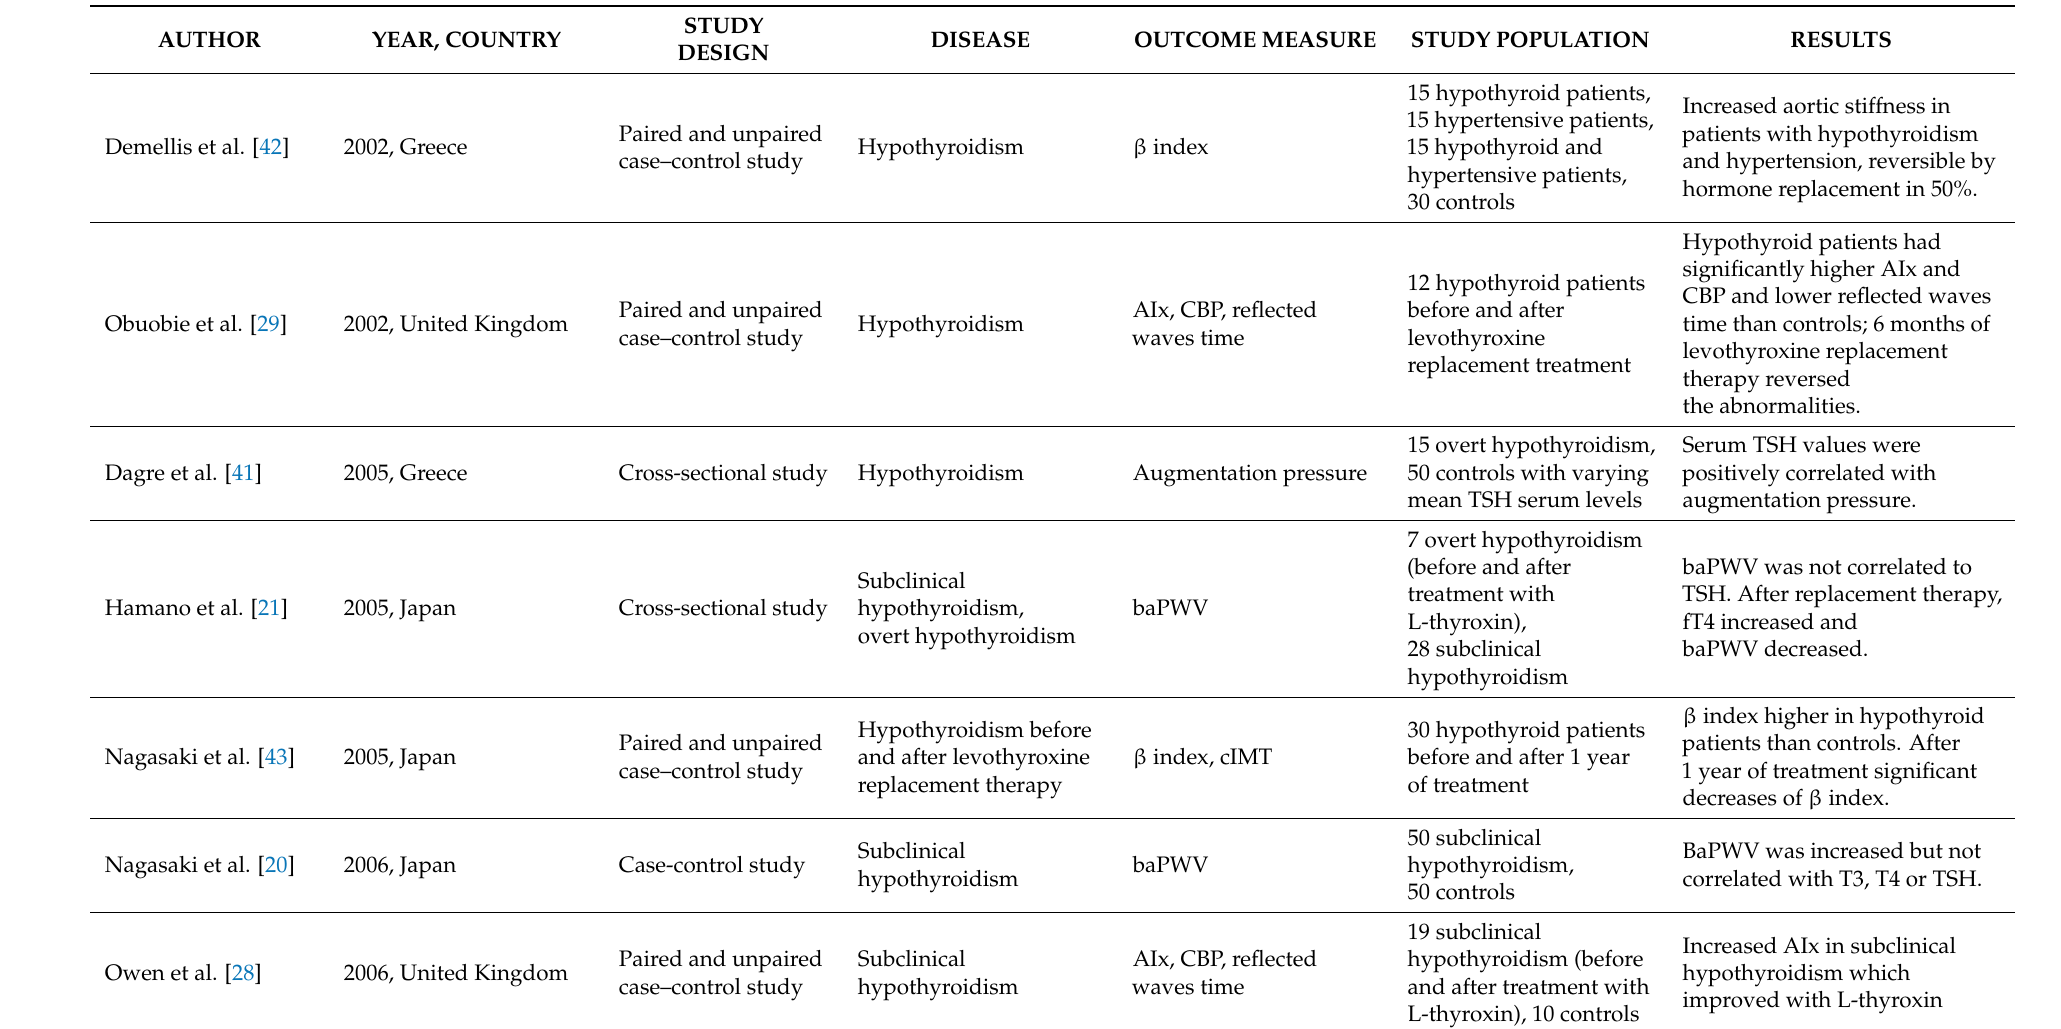
Table 1. Experimental studies evaluating arterial stiffness and